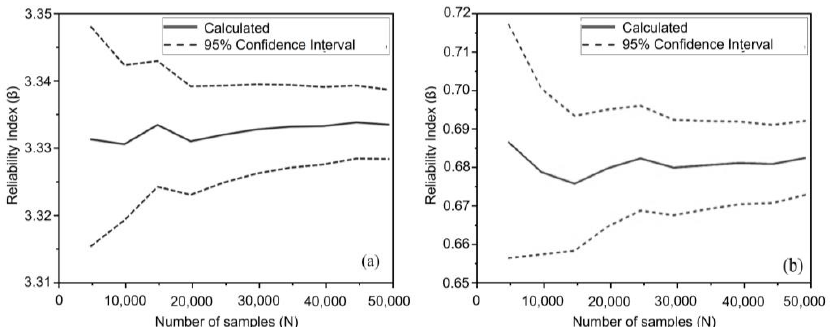
Figure 7. Reliability index vs. number of samples on the depassivation by ( a ) CO 2 and ( b ) Cl − diffusion.